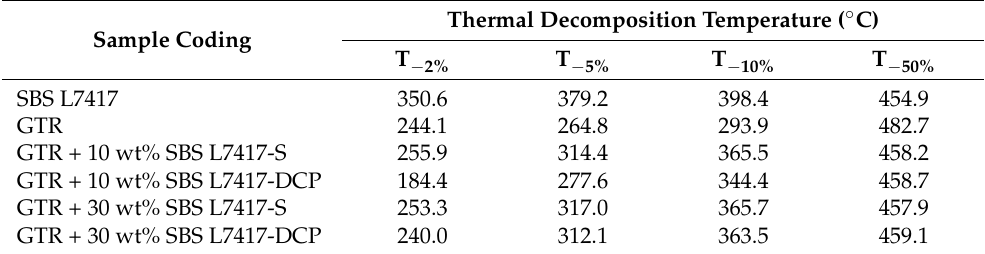
Table 4. Thermal decomposition characteristics of tested samples estimated from TGA